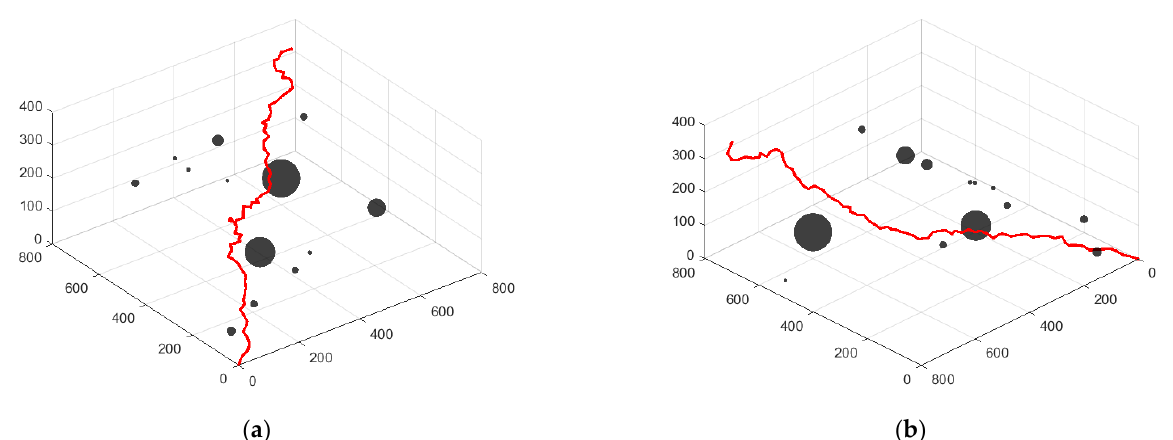
Figure 10. Different view of the path planning of the conventional RRT algorithm: ( a ) view 1; ( b ) view 2.